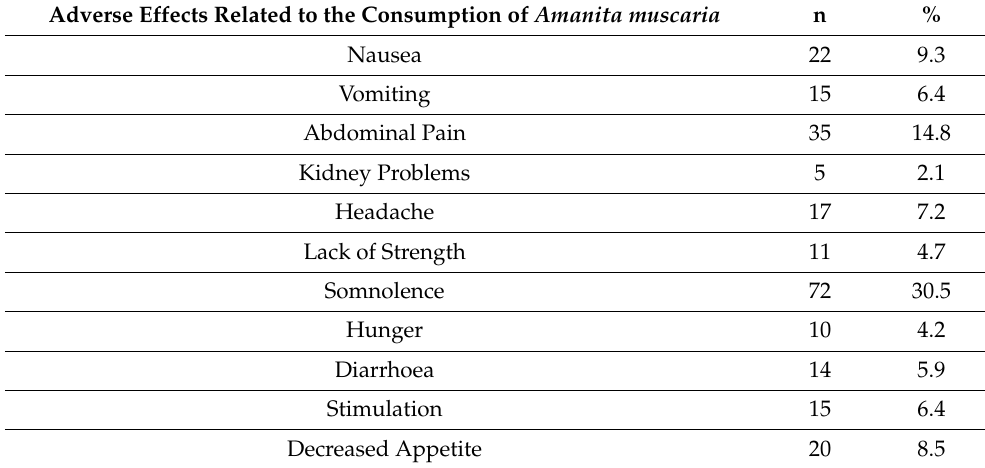
Table 3. Adverse effects that occurred in the study group after consumption of Amanita muscaria .